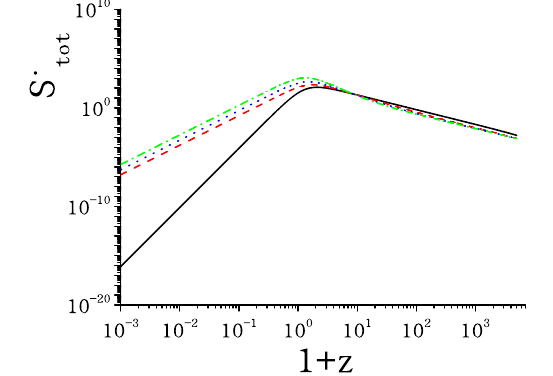
Fig. 1 The evolution of the entropy time-variation as a function of the redshift z given by (23), in the case of (cid:7) CDM background evo- lution (24), for various values of the Barrow exponent (cid:2) : (cid:2) = 0 (black—solid), (cid:2) = 0 . 3 (red—dashed), (cid:2) = 0 . 6 (blue—dotted), (cid:2) = 1 (green—dashed-dotted). We have imposed (cid:8) (cid:8) = 10 − 4 ,andwehaveusedunitswhere ¯ h = k r 0